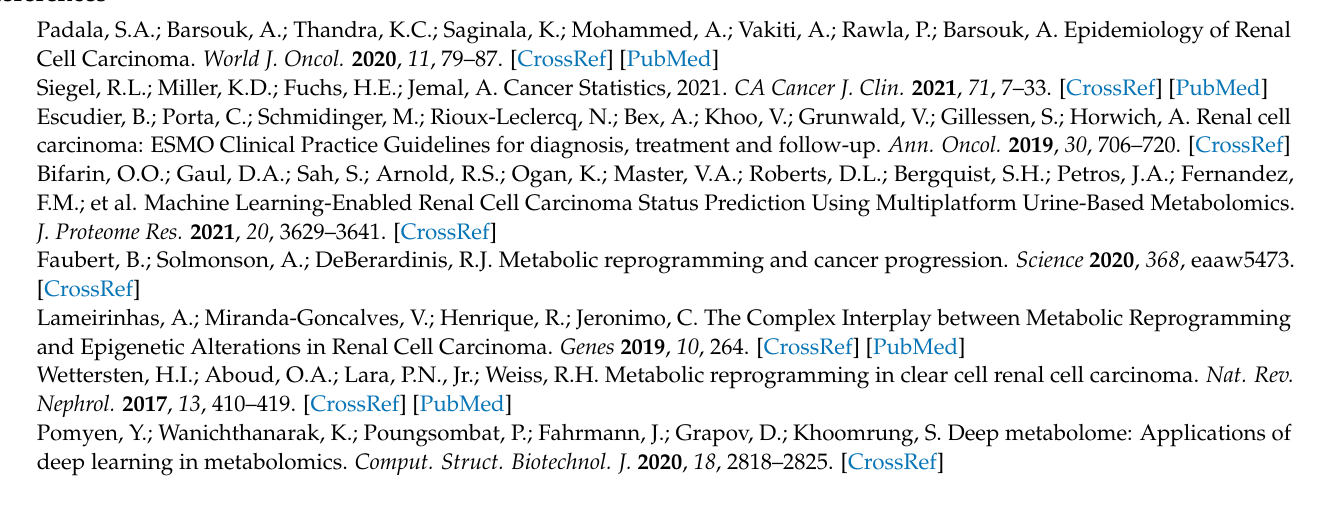
RCC patient cohort characteristics for the 82 subjects used for tumor size predictions; Table S3. MS metabolomic features used in RCC stage stratification with p -values < 0.05 and >1-fold change; Table S4. Machine learning prediction results for individual metabolites in the RCC staging metabolomic panel; Table S5. Demographics/clinical information for the healthy control cohort; Table S6. RCC staging markers that are statistically significant when RCC samples were compared with the healthy controls; Table S7. Metabolomic features identified as statistically significant when healthy controls were compared with early stage RCC; Table S8. Comparison of RCC staging markers in early staged RCC vs. healthy controls; Table S9. Metabolomic features identified as statistically significant when healthy controls were compared with advanced stage RCC; Table S10. Comparison of RCC staging markers in advanced staged RCC vs. healthy